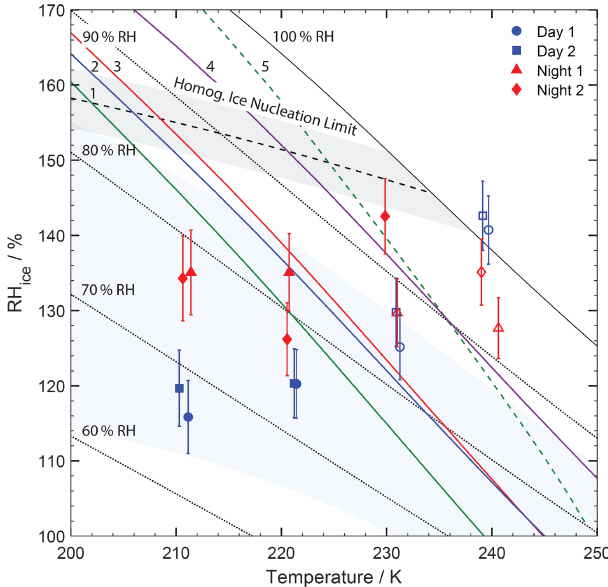
Figure 4. IMF – immersion freezing (open symbols) – and DIN – deposition ice nucleation (solid symbols) – for examined ACE-ENA particle samples are given as a function of T and RH ice . The data points and error bars reflect the mean of several measurements ac- counting for uncertainties in RH. Solid line represents conditions of water saturation (100% RH). Dotted lines indicate constant relative humidity (RH). Dashed line and grey shading represent the homo- geneous freezing limit for droplets of 10µm in size and correspond- ing uncertainty (Koop, 2004; Koop et al., 2000). The glass transition temperature of laboratory-generated α -pinene SOA (green line or 1, Charnawskas et al., 2017), naphthalene SOA (blue line or 2, Char- nawskas et al., 2017) field-derived SOA (red line or 3, Wang et al., 2012b), and Suwannee River Fulvic Acid (SRFA) particles (dark violet line or 4, Wang et al., 2012b) are plotted. The dashed green line (or 5) displays the FDRH for α -pinene SOA particles, 500nm in diameter, under the humidification rate of this experiment (Char- nawskas et al., 2017). The light bluish area indicates the conditions for pore condensation freezing for pore sizes of 7.5 to 20nm (Mar- colli, 2020,